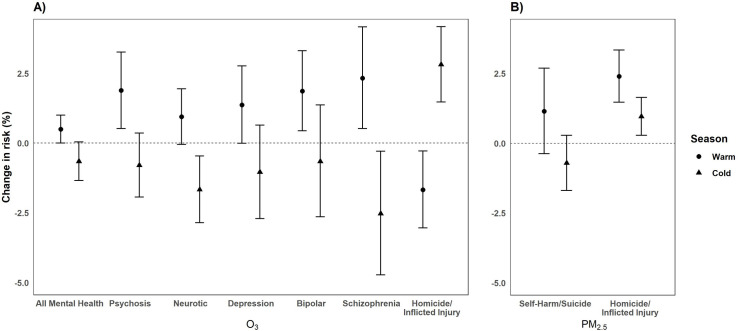
Percentage change (95% CI) in the risk of ED visits for O3 (per 10 ppb increase) (A) and PM2.5 (per 10μg/m3 increase) (B) by season from 2005–2013 in California.1 Bars: 95% Confidence Interval; CI: Confidence Interval; Warm: (May-October), Cold: (November-April); ppb: parts per billion. 1Only significant outcomes shown.